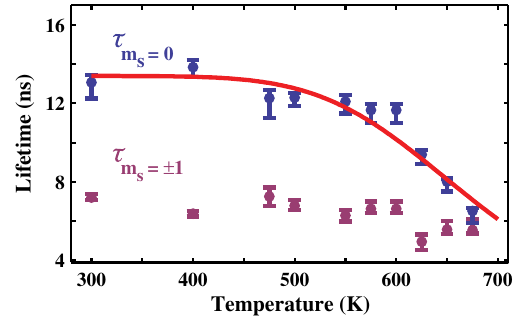
ð T Þ FIG. 2. Temperature-dependentexcited-statelifetimes, (cid:1) m s ¼ 0 ð T Þ (magenta), for a single NV center. The error (blue) and (cid:1) m s ¼(cid:2) 1 bars reflect fitting uncertainties (68% intervals). The red line is the ð T Þ with (cid:1) ð 300 K Þ ¼ 13 : 4 ns , Mott-Seitz formula for (cid:1) m m s ¼ 0 s ¼ 0 s ¼ 3420 , and (cid:1) E ¼ 0 : 48 eV m s ¼ 0